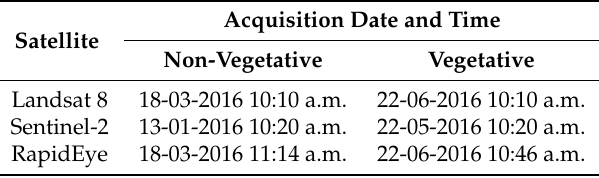
Table 1. Acquisition date and time for satellite images. Time is given in Greenwich Mean Time